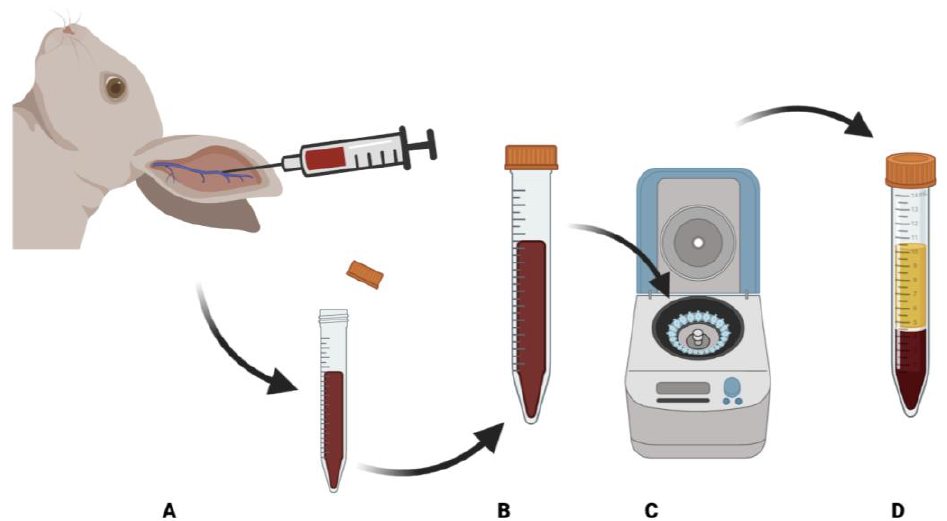
Figure 3. ( A ) Ear vein puncture in the rabbit using a syringe with a needle ranging between 21 to 23G; ( B ) Blood placed in a tube/falcon (without additives); ( C ) The tube is then quickly placed in the centrifuge, following protocols for PRF production, rpm, time, and RCF; ( D ) PRF is produced after following the previous steps.